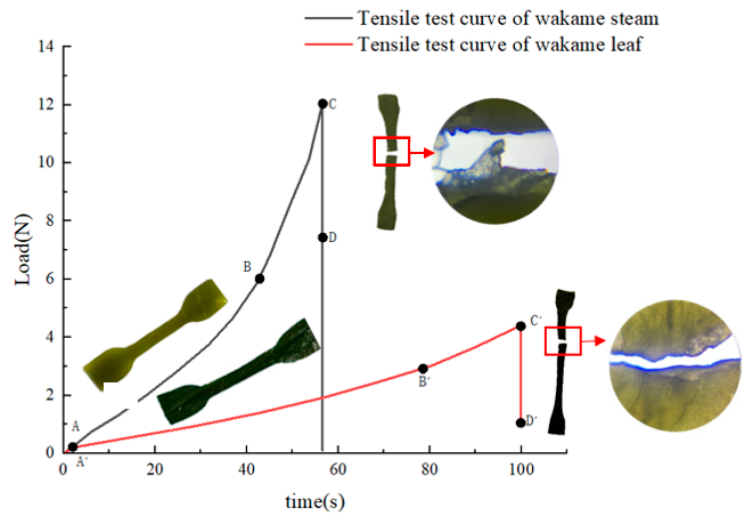
Figure 13. Force–time curve of typical wakame stem and leaf tensile test.